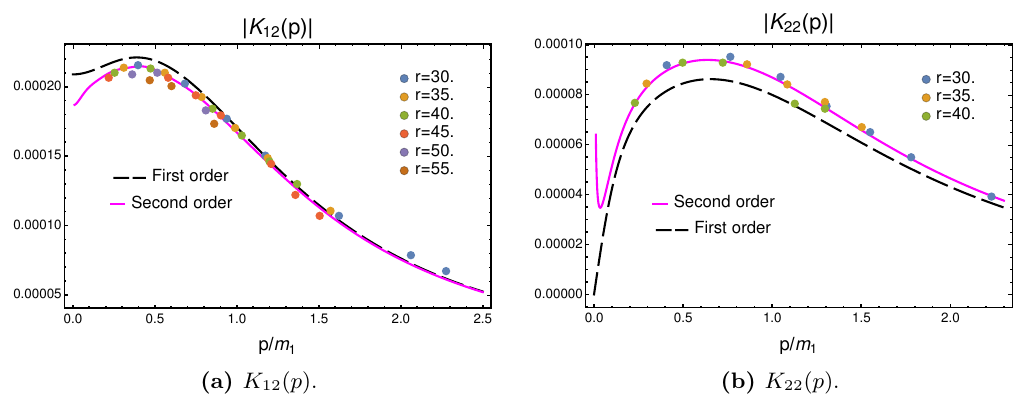
Figure 4 . Overlap functions of pairs of heavier particles after a quench of size ξ = 0 . 05 along the E 8 axis. Conventions are as in figure